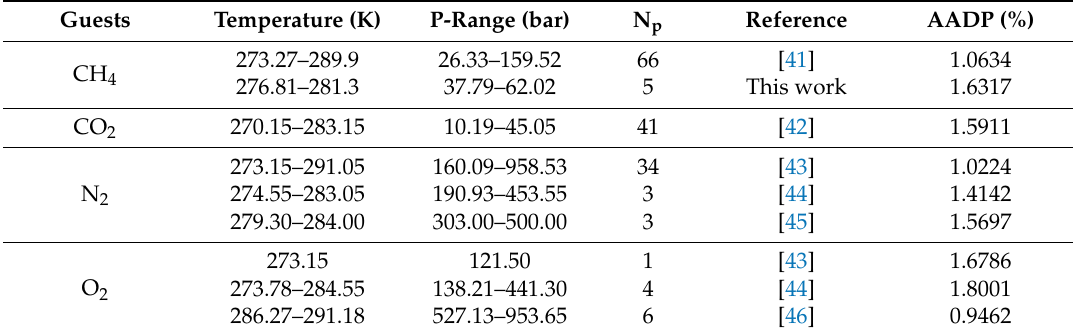
Table 5. The phase equilibrium pressure and temperature range of experimental data and the Average Absolute Deviation in Pressure (AADP) for predicted results.